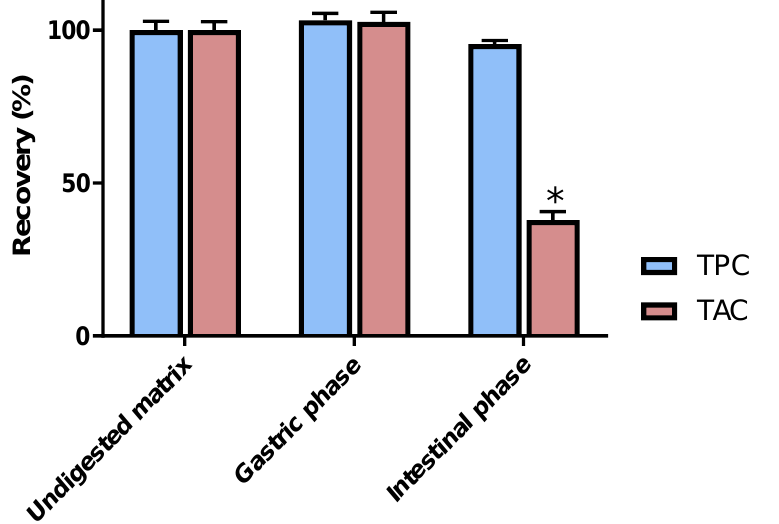
Figure 2. Impact of gastrointestinal simulated digestion on the Total Phenolic Content (TPC) and Total Anthocyanin Content (TAC) of cyandin-3- O -glucoside samples. Values are presented as means ± SEM ( n = 3). All results are expressed as percentages, with the control (i.e., the undigested matrix) normalized as 100%. * p < 0.05 vs. control.